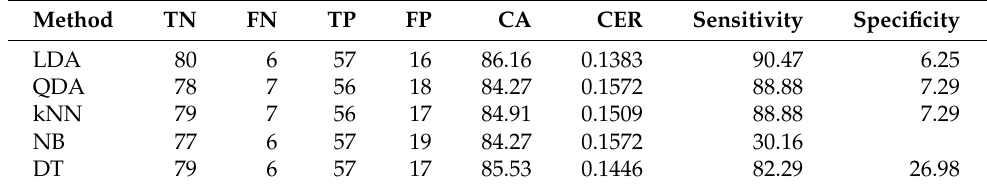
Table 12. The classification results obtained for statistical methods; see abbreviations in Nomenclature.